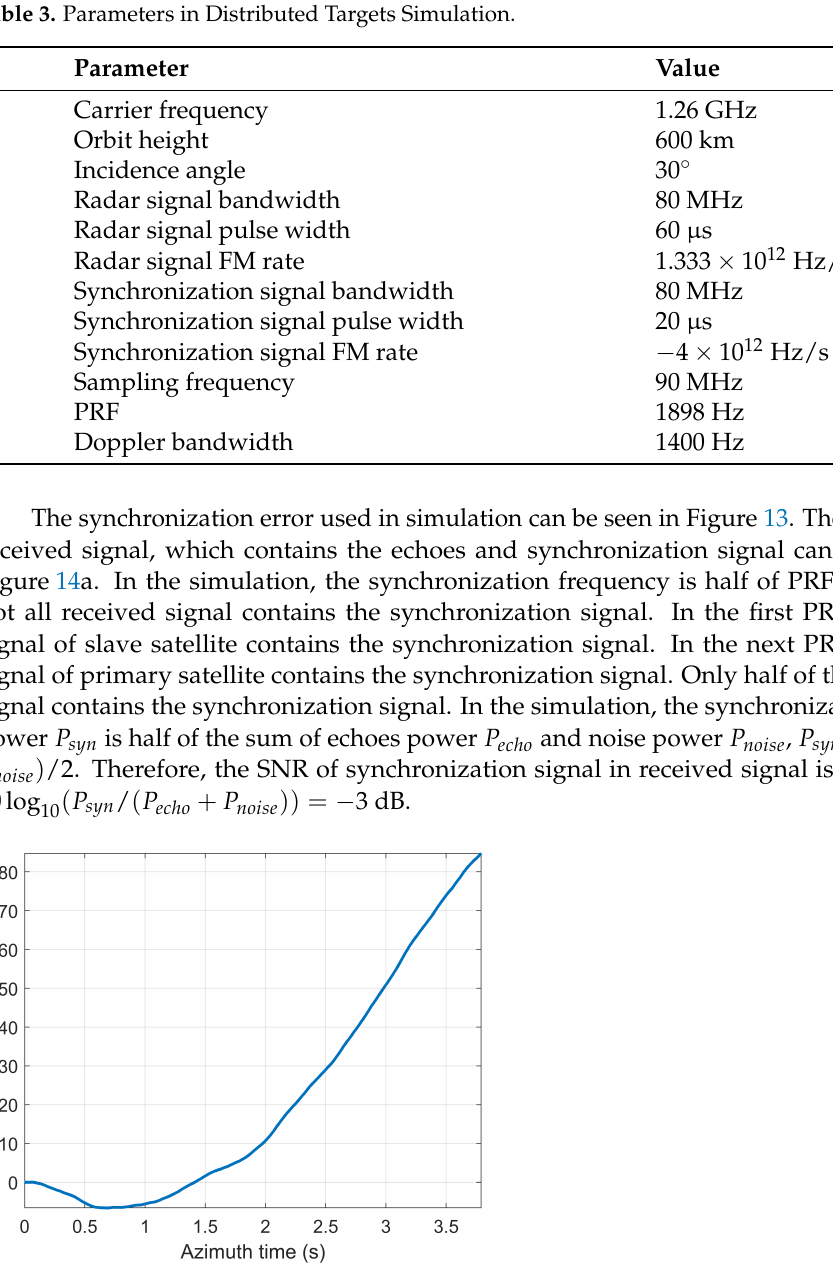
Figure 13. The preset synchronization phase error in distributed targets simulation